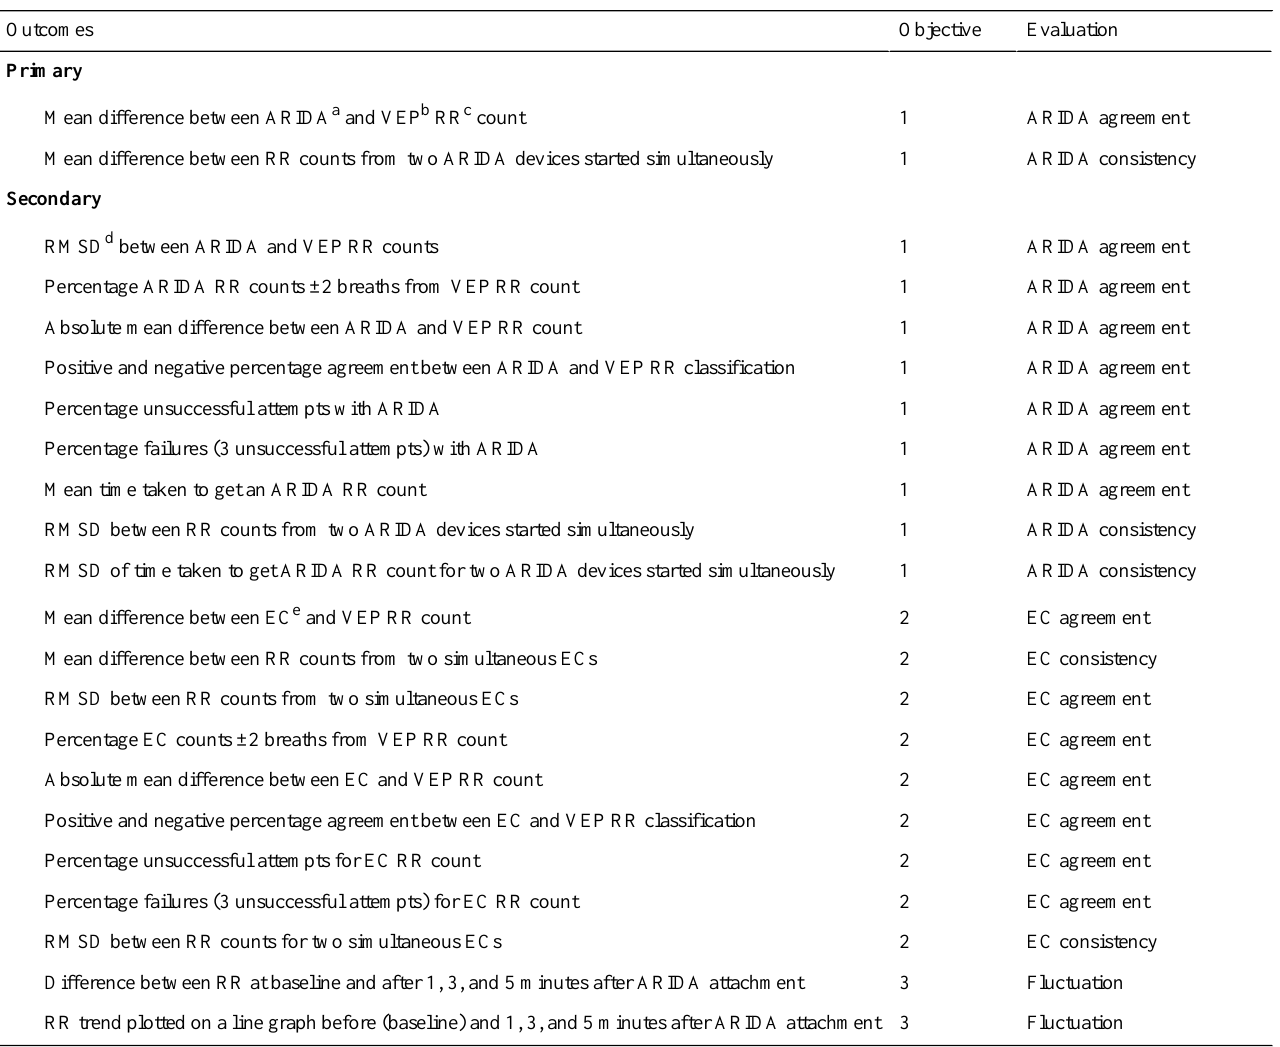
Table 1. Primary objective and outcome